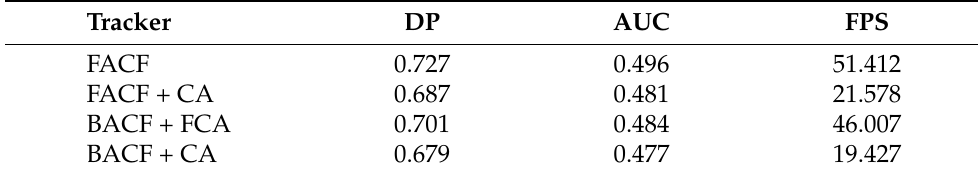
Table 4. Performance with different context learning strategies on DTB70 [25] benchmark.